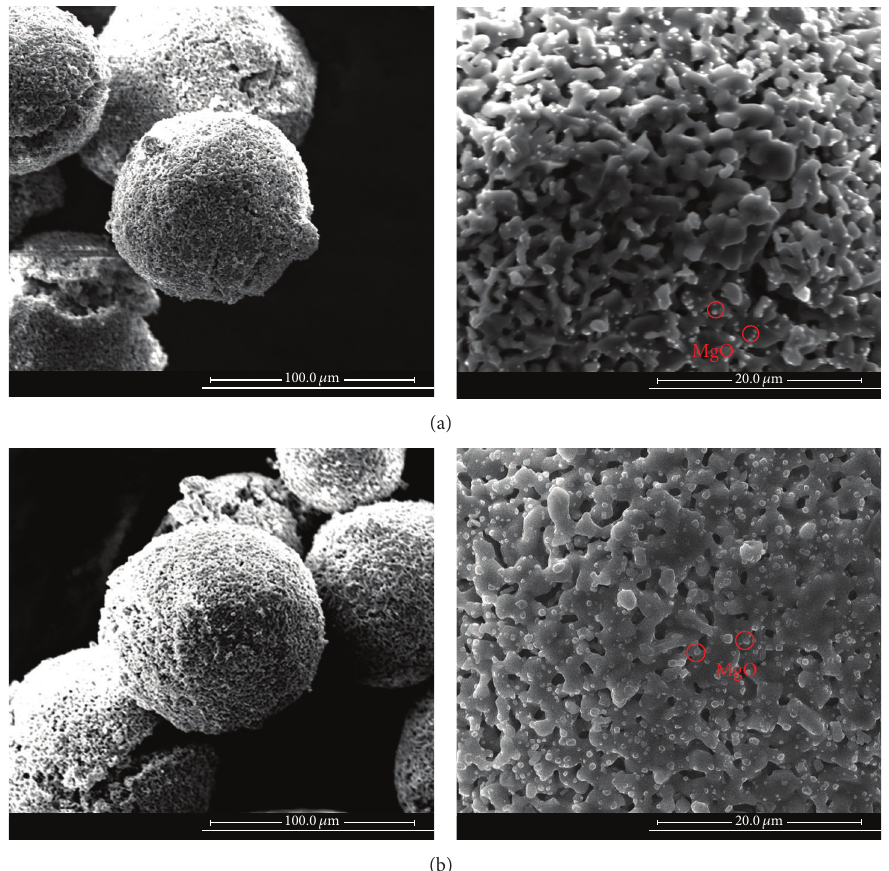
Figure 15: SEM image of 5.6% MgO 1300 sample. (a) Fresh sample. (b) Used sample (cooled down to room temperature by 5% O 2 in N 2